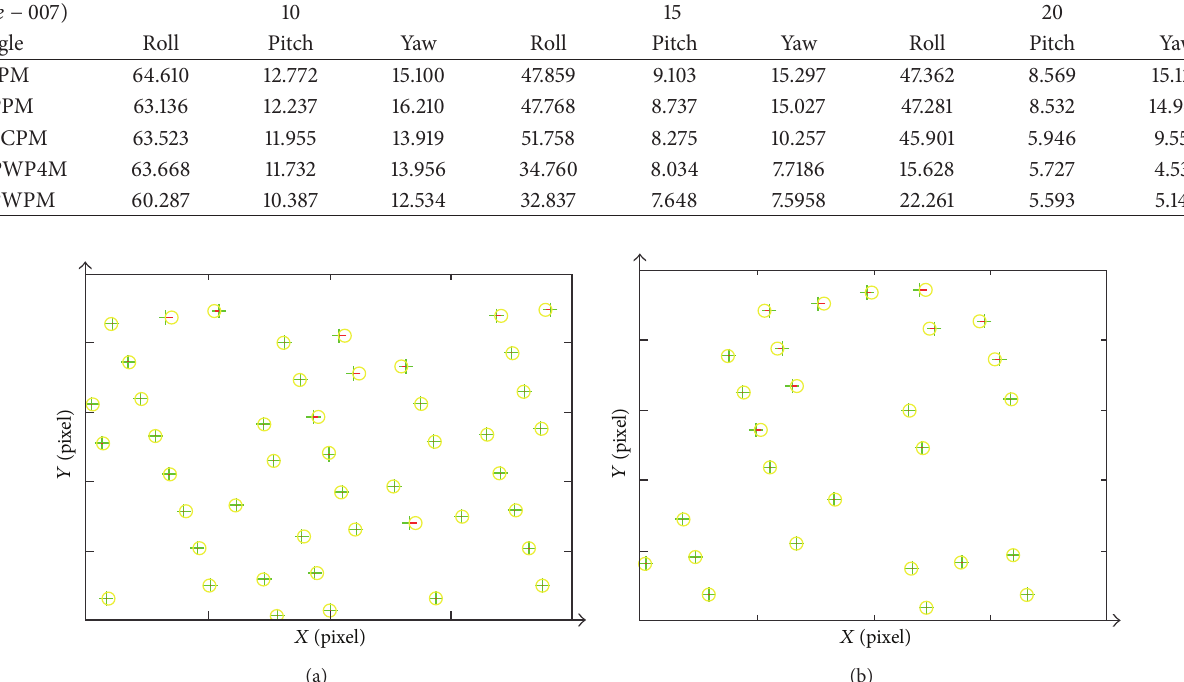
Figure 7: Diagram of geometric correction: (a) the residuals of GCP; (b) assessment with CP.